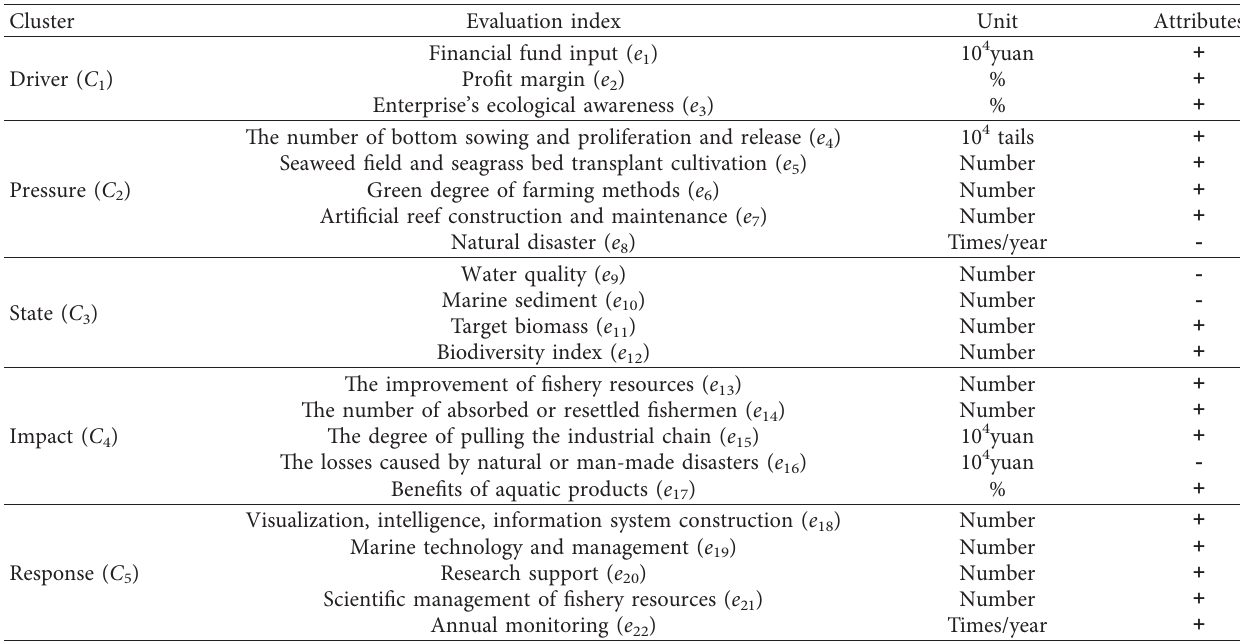
Table 1: MRES evaluation index